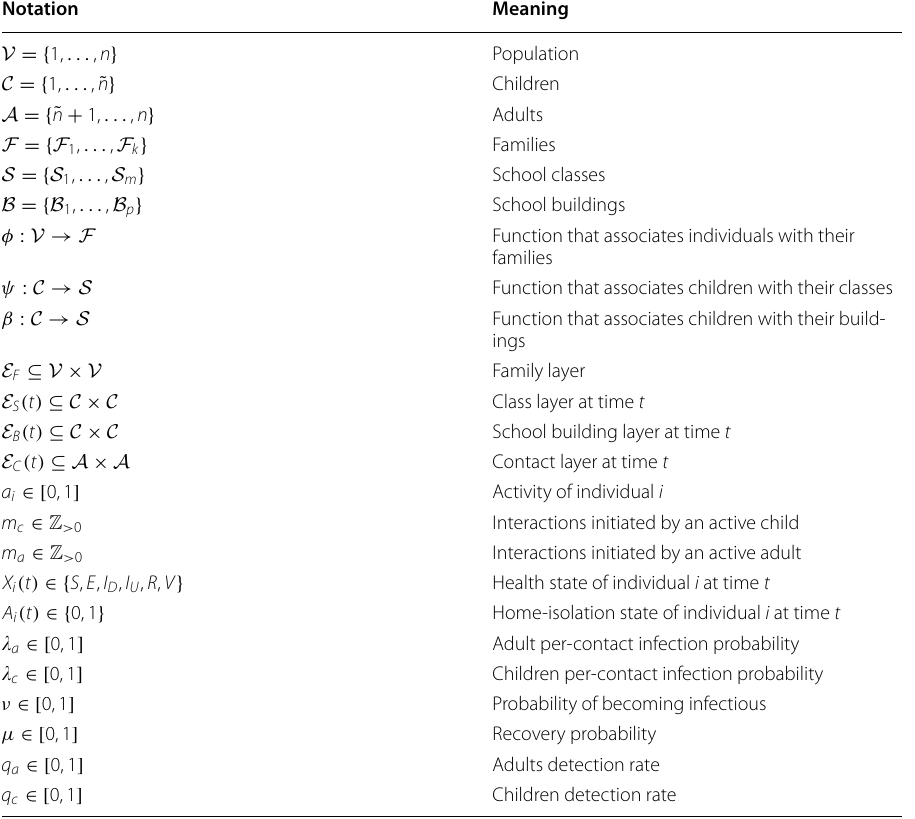
Table 1 Notation used in the paper Notation